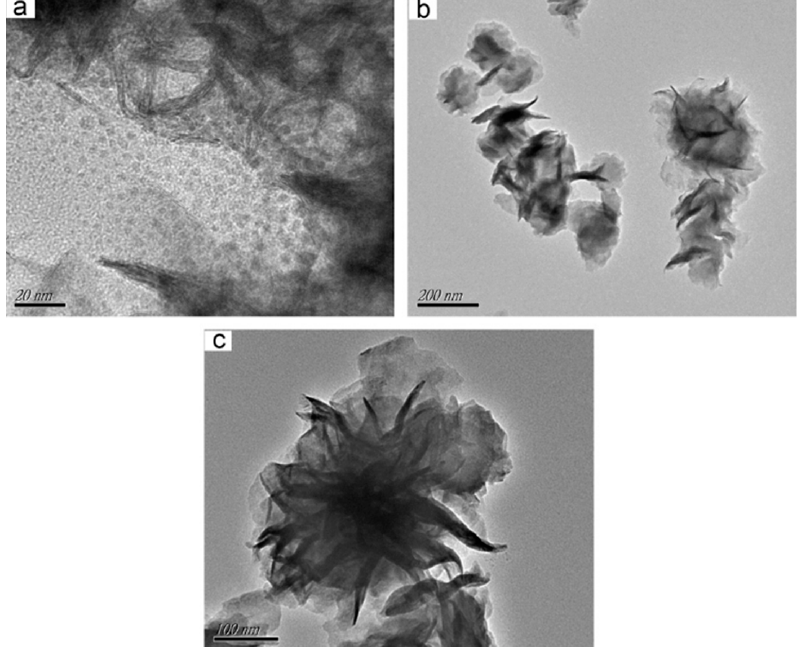
Figure 6. TEM images of MoS 2 samples obtained under different reaction times (( a ): 6 h, ( b ): 12 h, ( c ): 48 h) from [29]. Reprinted with permission from [29]. Copyright 2012. Elsevier.